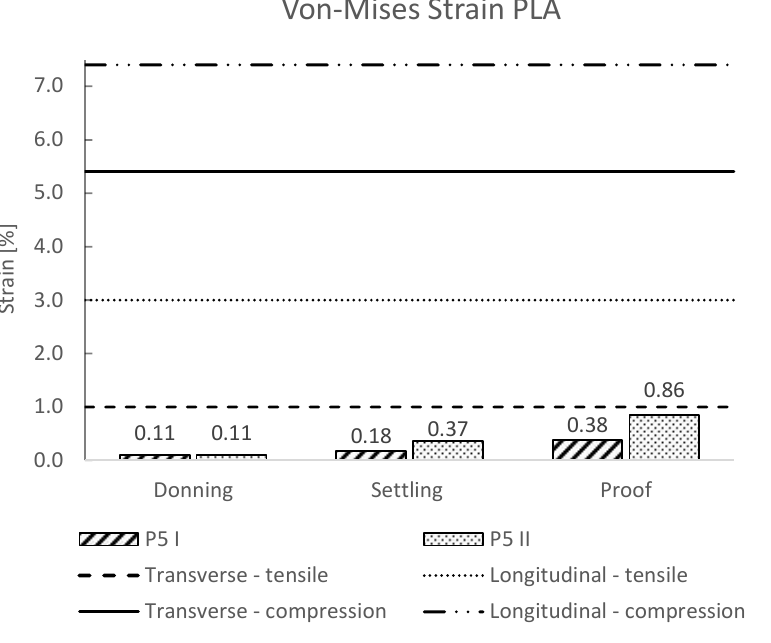
Figure 5. Von-Mises strain of the 3D-printed PLA socket for the loading cases P5 I and P5 II. Additionally, the transverse and longitudinal yield strains are shown with horizontal dashed